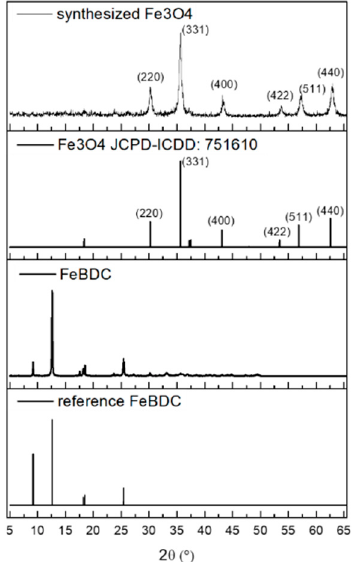
ff raction (XRD) spectra of FeBDC, Fe Figure 3. X-ray Diffraction (XRD) spectra of FeBDC, Fe 3 O 4 , and their respective references. Figure 3. X-ray Di